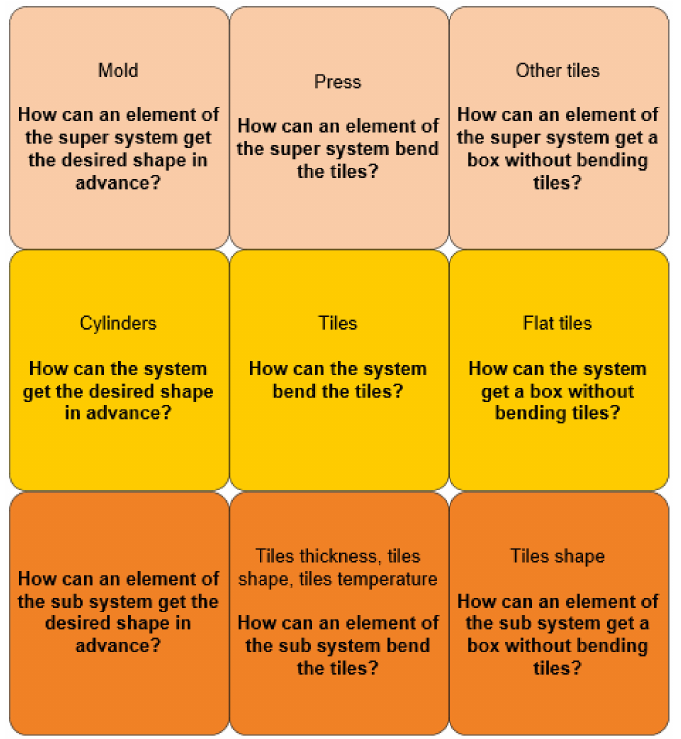
Figure 7. The second SO built for the case study by following the proposed alternative approach.